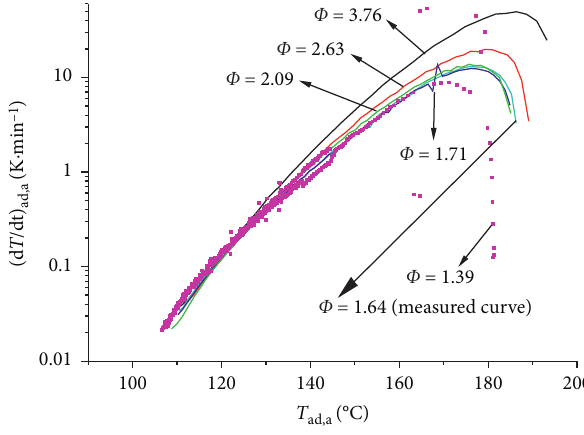
Figure 9: (d T /d t )- T corrected to Φ Table 9: The parameters corrected to Φ